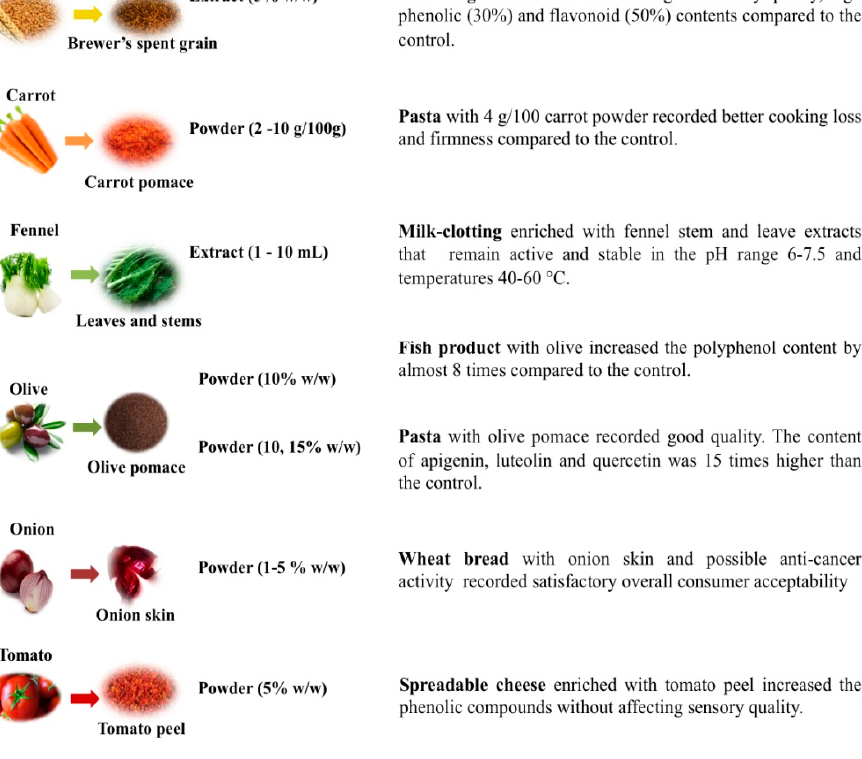
Figure 1. Applications of vegetable by-products as food ingredients.